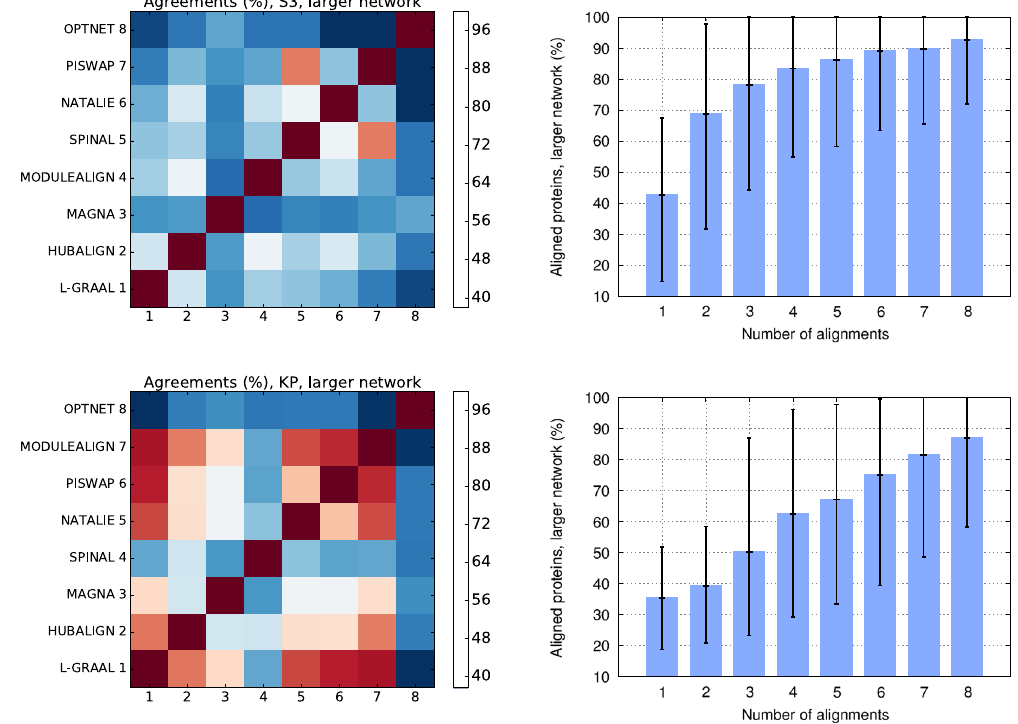
Figure 3. Agreements across aligners. We first consider the alignments that have the maximum topological similarity (S 3 ). In the top-left panel, we report for each pair of aligners the average overlap between the proteins that they map on the larger networks, described by their node mapping agreement score. In the top-right panel, we report the average percentage of proteins from the larger networks that are aligned to some proteins from the smaller networks when considering simultaneously k different alignments (e.g., from k different aligners), with k = 0 (e.g., no alignment) to 8 (when considering one alignment form each of the eight aligners). Alignments are successively added according to the performance of the aligners for the considered score (best aligner first); i.e., aligners are considered in the following order: L-GRAAL, MAGNA, HUBALIGN, MODULEALIGN, NATALIE, SPINAL, PISWAP and OPTNET. The bottom-panels show analogous but when considering the alignments that have maximum biological similarity (KP) and aligners are considered in the following order: L-GRAAL, PISWAP, NATALIE, HUBALIGN, SPINAL, MAGNA, MODULALIGN and OPTNET (for the reasons analogous to